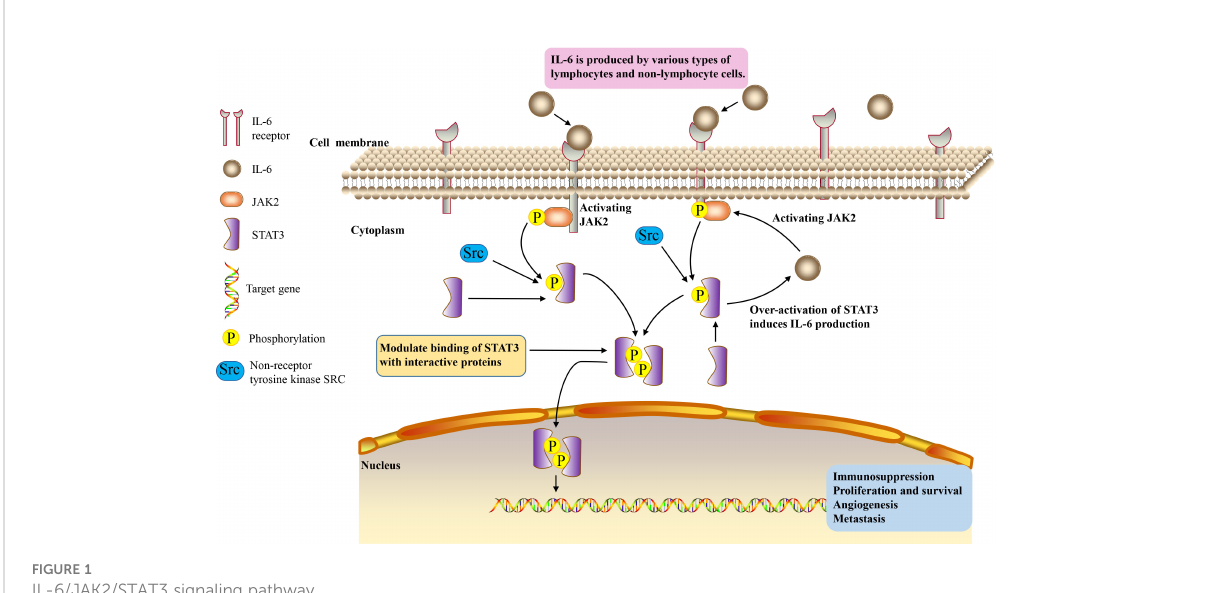
FIGURE 1 IL-6/JAK2/STAT3 signaling